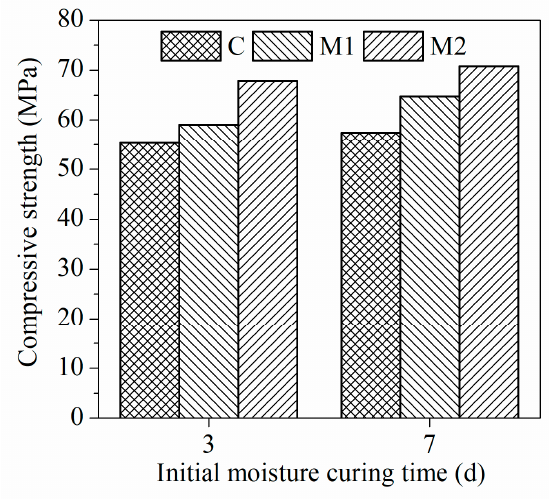
Figure 6. The 28-d compressive strength with different initial moisture curing time. The visual appearance of samples C, M1 and M2 exposed to sulphate attack for different ages is shown in Figure 7a–c, respectively. The numbers marked in Figure 7 refer to the initial moisture curing time. Many salt crystals precipitate from the upper parts of the mortars and tend to increase with prolonged semi-immersion time. In the process of semi-immersion, no obvious cracks appear on the surfaces of all mortars. The relative compressive strengths of the mortars after different semi-immersion times are shown in Figure 8a. When the mortars were initially moisture cured for 3 d, the relative compressive strength of all mortars after 28 d of semi-immersion are less than 100%. However, the relative compressive strengths for certain mortars after 56 d and 90 d of semi-immersion are more than 100%, especially for plain cement mortar. When the mortars are initially moisture cured for 7 d, the relative compressive strengths of almost all mortars after semi- immersion are less than 100%. Therefore, from the results for the relative compressive strengths, prolonging the initial moisture curing time has an adverse effect on the sulphate attack resistance. This is unreasonable. Previous studies have shown that prolongation of the initial moisture curing time is beneficial to cement hydration and pore structure development, and sulphate attack resistance should not decrease with prolongation of the initial moisture curing time [23,27]. Therefore, the compressive strength cannot be used as an index to evaluate sulphate attack resistance of rectangular mortars in semi-immersion tests. The flexural strength losses of mortars after different semi-immersion times are shown in Figure 8b. Apparently, the flexural strength losses of mortars decrease with increasing ultrafine metakaolin at any semi-immersion age. When the semi-immersion time is the same, prolonging the initial moisture curing time has little impact on the flexural strength loss of samples C and M1. However, compared to the flexural strength loss for 3-d initial moisture curing, the flexural strength loss of sample M2 for 7-d initial moisture curing is relatively low. The addition of ultrafine metakaolin significantly improves the sulphate attack resistance of mortar, and the sulphate attack resistance also significantly improves with increasing ultrafine metakaolin. Therefore, in the semi-immersion test, it is reasonable to evaluate the sulphate attack resistance of mortar by flexural strength